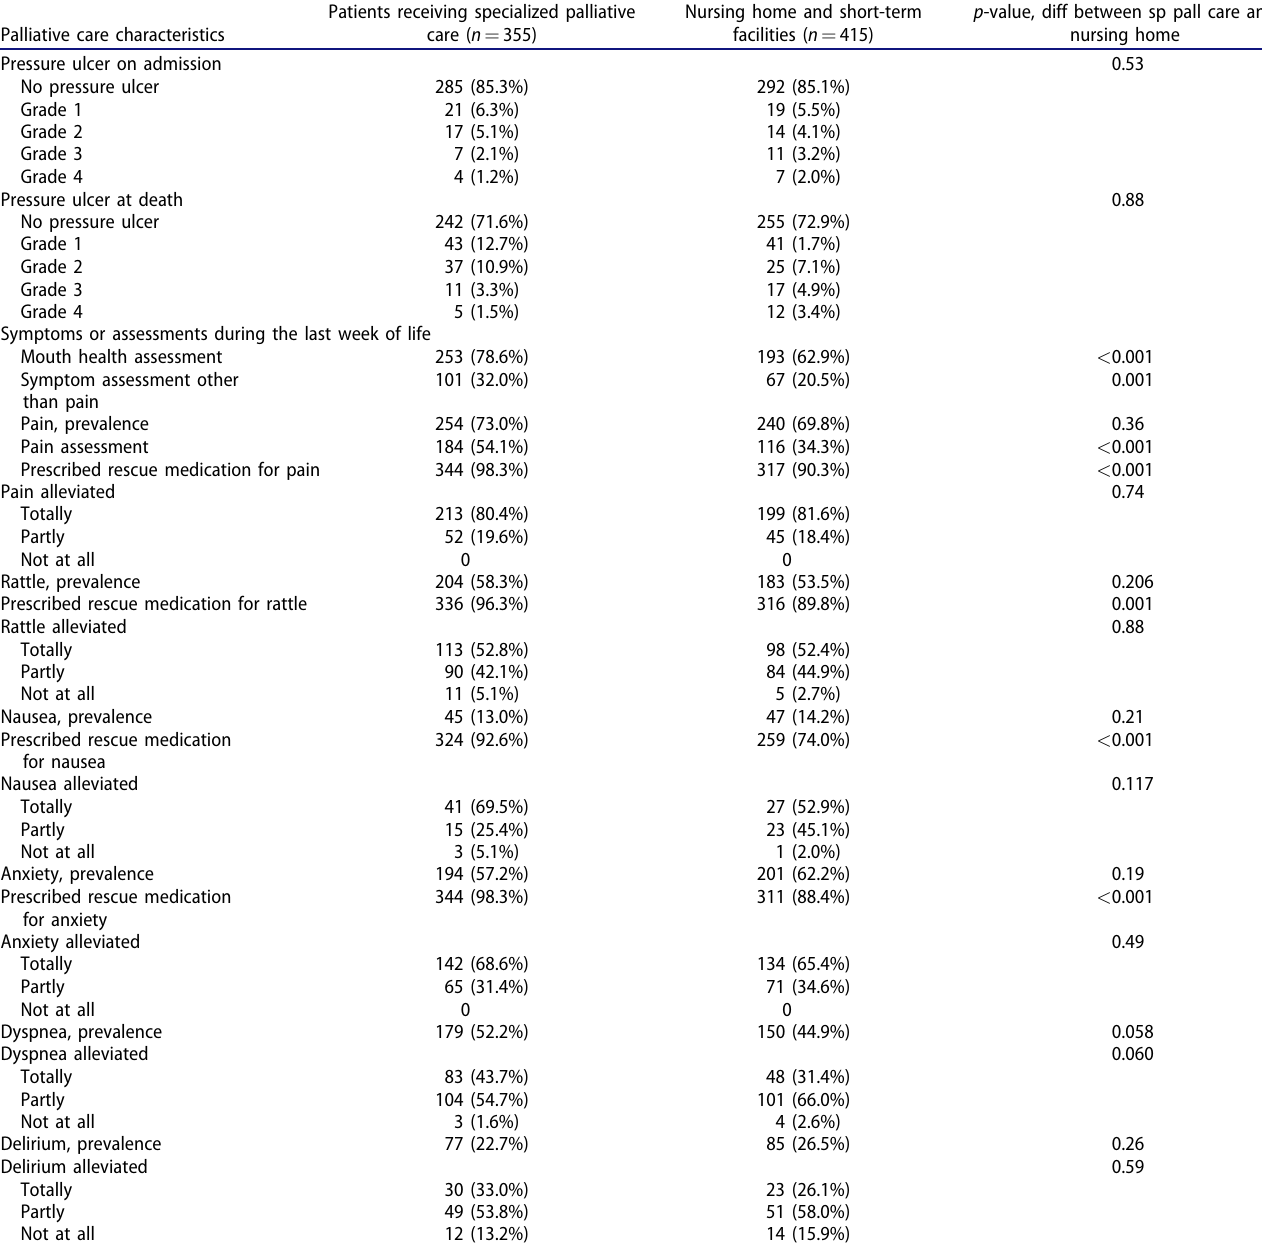
Table 2. Characteristics of symptom experience, assessment, and management registered in specialized palliative care and in nursing homes. Patients receiving specialized palliative Palliative care characteristics care ( n ¼